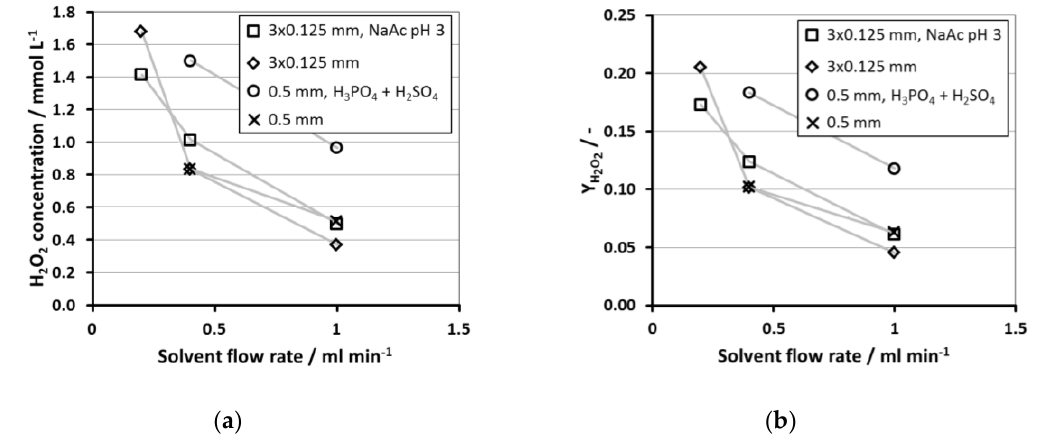
Figure 6. ( a ) Hydrogen peroxide concentration and ( b ) yield over solvent flow rate using 100 mg Pd/TiO 2 in fixed bed in a PVC-tube at 10 bars system pressure with water with additives as solvent: squares: 3 × 0.125 mm deep microchannel, 180 µ m Nafion ® membrane, 5 mM NaBr, NaAc buffer, pH 3 (Table 1 Exp.-Nr.: 49–50), diamonds: 3 × 0.125 mm deep microchannel, 180 µ m Nafion ® membrane, 5 mM NaBr (Table 1 Exp.-Nr.: 46–48), circles: 0.5 mm deep microchannel, 30 µ m Nafion ® membrane,